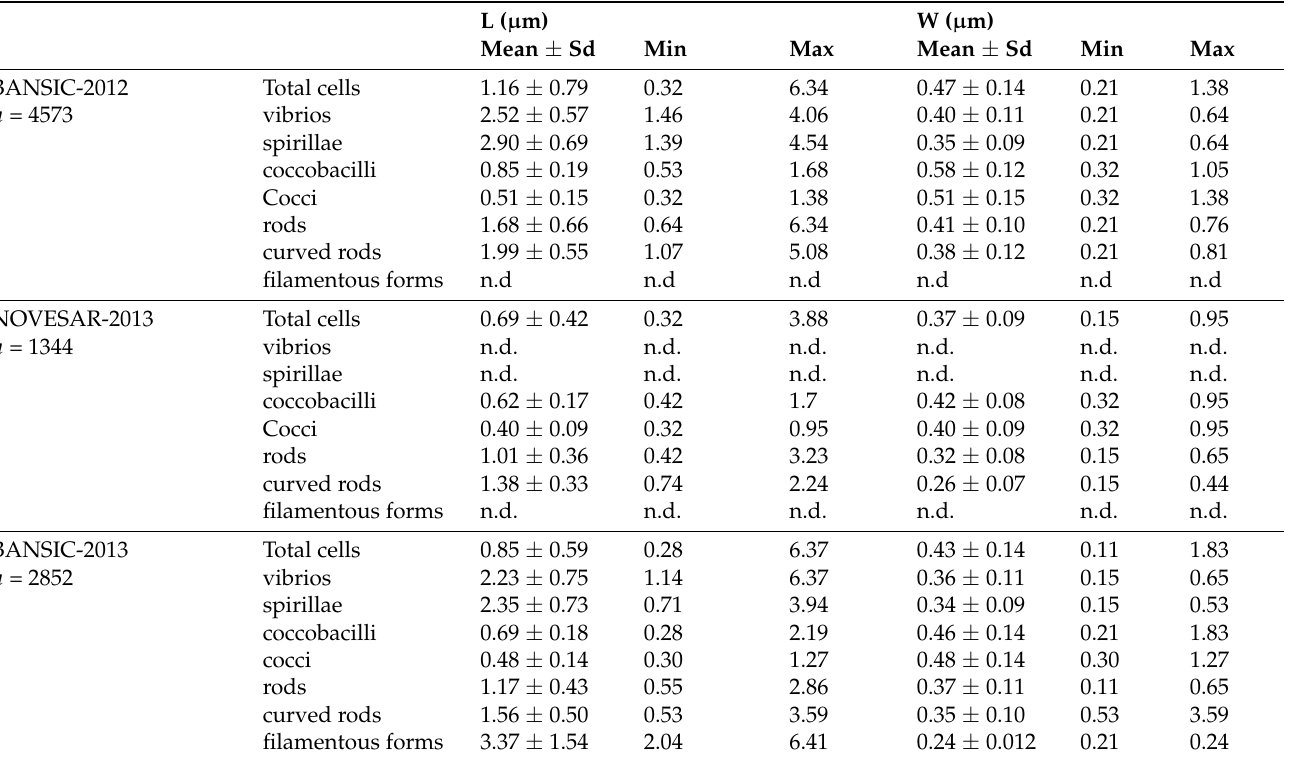
The morphometric data on prokaryotic types are summarised in Table 3. Table 3. Morphometrical dataset: average cell measures on total cells and per morphotype ( n = the number of cells measured); averaged volumes and s.d. per each morphotype. L = Length; W = Width. n.d. = not